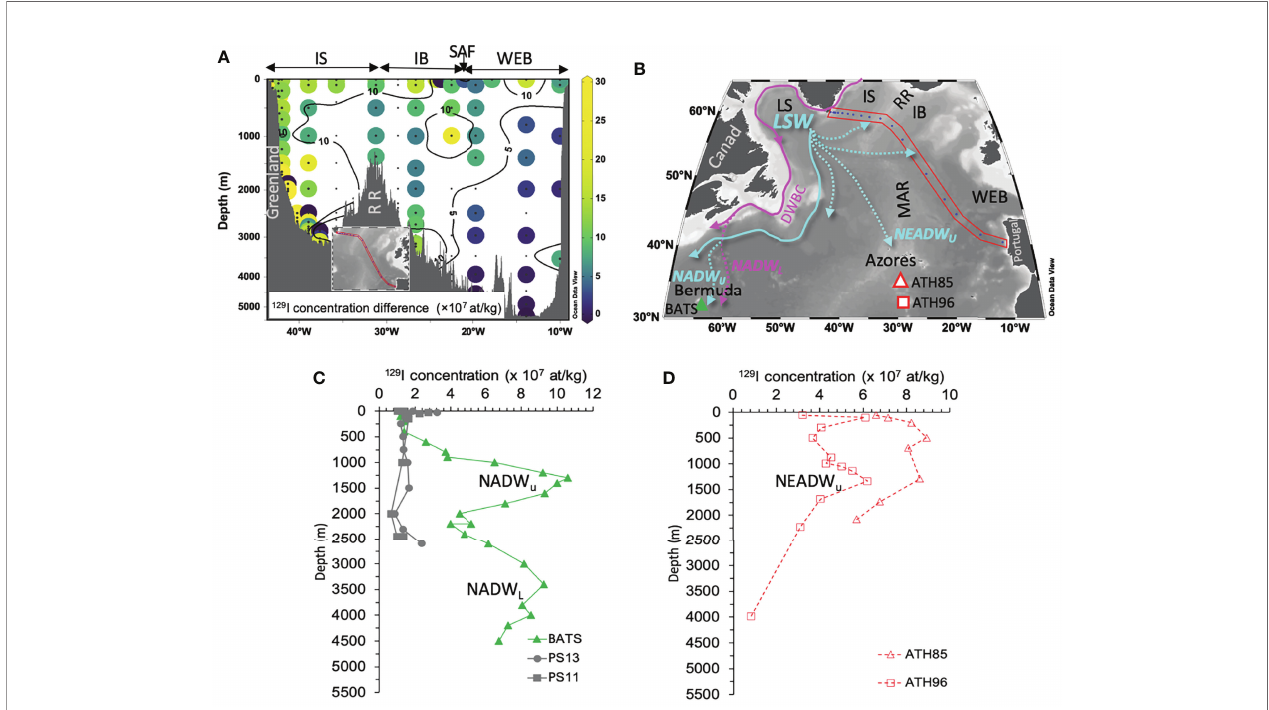
FIGURE 5 | (A) Temporal change of 129 I concentrations along the OVIDE line between 2014 (Castrillejo et al., 2018) and 2018 (this study) estimated as the subtraction of 2014 tracer values from 2018 observations overlapping at similar locations. (B) Map with the section plotted in (A) and the location of 129 I depth pro fi les at (C) BATS and (D) ATHENA stations in the subtropical North Atlantic. Plot (C) includes the two 129 I depth pro fi les sampled in 1993-1994 near the northeastern American slope at stations 13 (PS13, 36.3981°N, 74.2358°E) and 11 (PS11, 36.5081°N, 74.0908°E) reported by Peter H. Santschi et al. (1996). Acronyms in fi gure: Deep Western Boundary Current, (DWBC); Iceland Basin, (IB); Irminger Sea, (IS); Labrador Sea, (LS); Labrador Sea Water, (LSW); Mid Atlantic Ridge, (MAR); North Atlantic Deep Water, (NADW); North East Atlantic Deep Water, (NEADW); Reykjanes Ridge, (RR); Sub-Arctic Front, (SAF); and West European Basin,